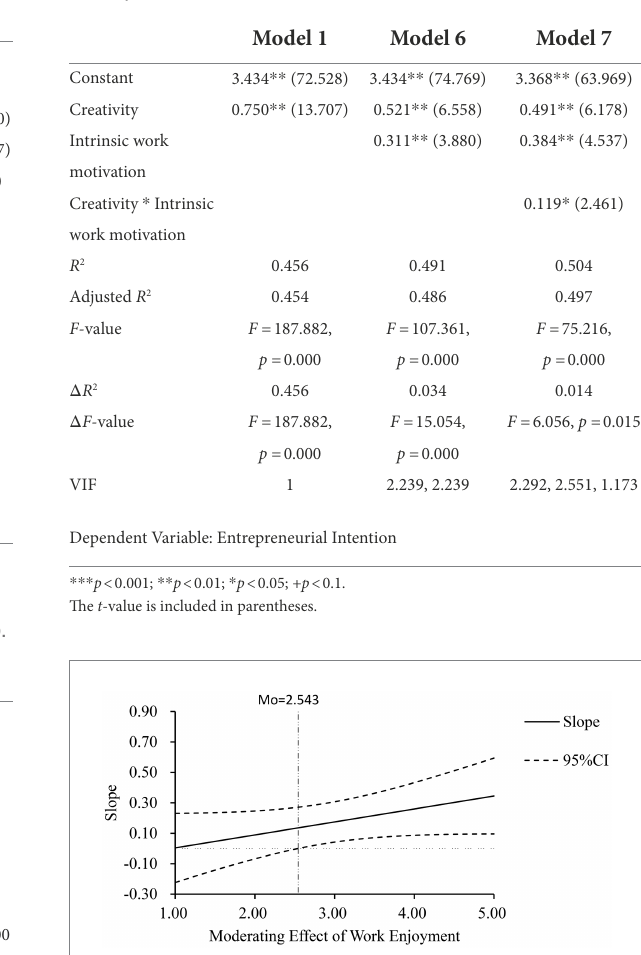
TABLE 7 Moderating effect analysis (intrinsic work motivation; N = 226).